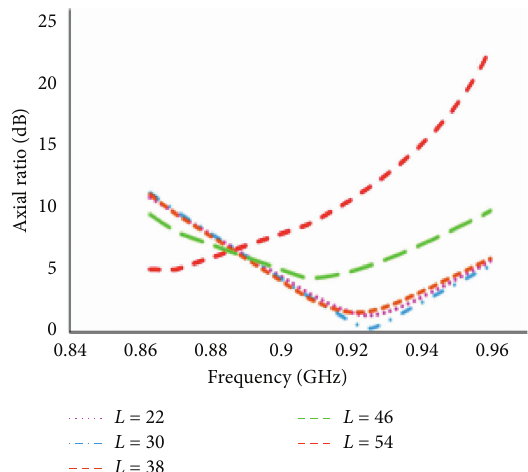
Figure 5: Microstrip stub length variation results in AR.